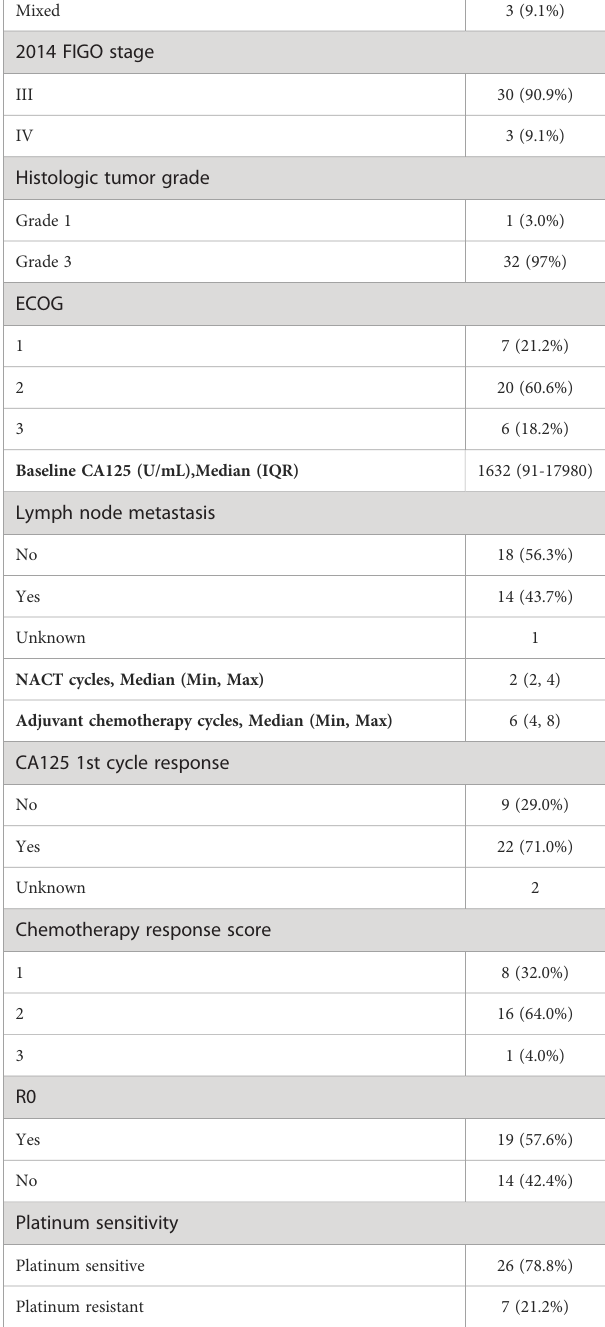
FIGO, International Federation of Gynecology and Obstetrics; ECOG, Eastern Cooperative Oncology Group score; NACT, neoadjuvant chemotherapy; IQR, interquartile